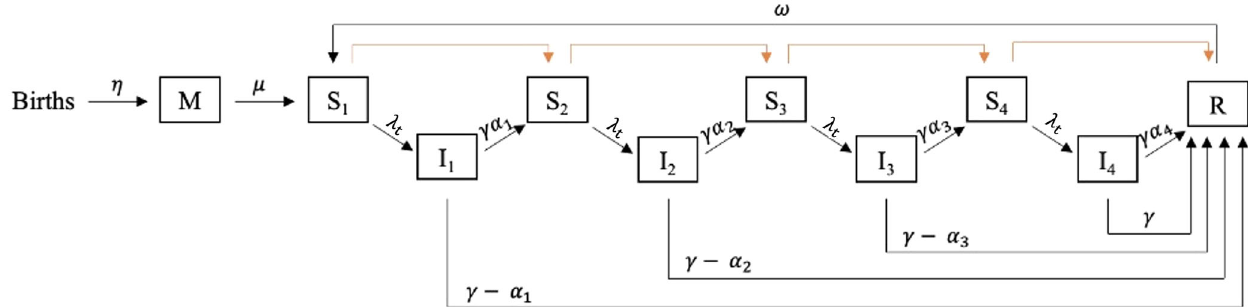
Fig. 3 The structure of the transmission model. After birth, children have maternal immunity to the virus and enter the “ M ” class. When maternal immunity wanes, children become fully susceptible to infection (S1 class). After a child becomes infected (I1 class), they will either become susceptible to subsequent infection (S2 class) or fully recover and gain immunity (R class). This continues until the child reaches a fourth infection, after which they become fully recovered (R class). Infection becomes less severe with each subsequent infection. Immunity wanes and an individual will eventually become susceptible to infection again (re-enter the S1 class). The orange arrows represent the effect of vaccination. After each dose of vaccine, vaccinated individuals move to the next class of susceptibility.